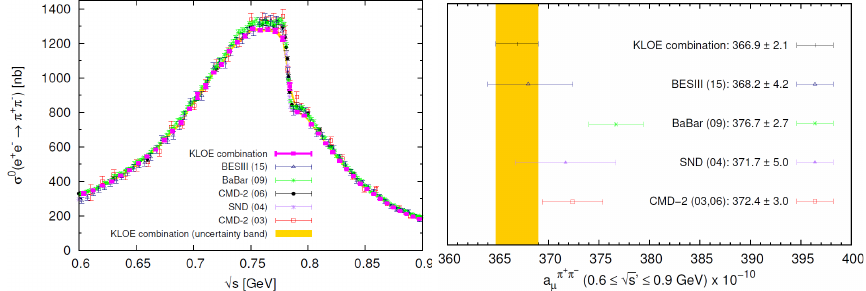
Figure 3. Left panel: the π + π − cross section from the KLOE combination [18] compared with CMD- 2 [19–21], SND [22], BaBar [23] and BESIII [24] data. The uncertainty on the KLOE combination is represented by the yellow band. Right panel: estimates of a π + π − from the KLOE combination [18], µ combined CMD-2 [19–21], SND [22], BaBar [23] and BESIII [24] in the 0.6–0.9 GeV range. The yel- low band represents the KLOE combination uncertainty. All the uncertainties shown are the statistical and systematic uncertainties summed in